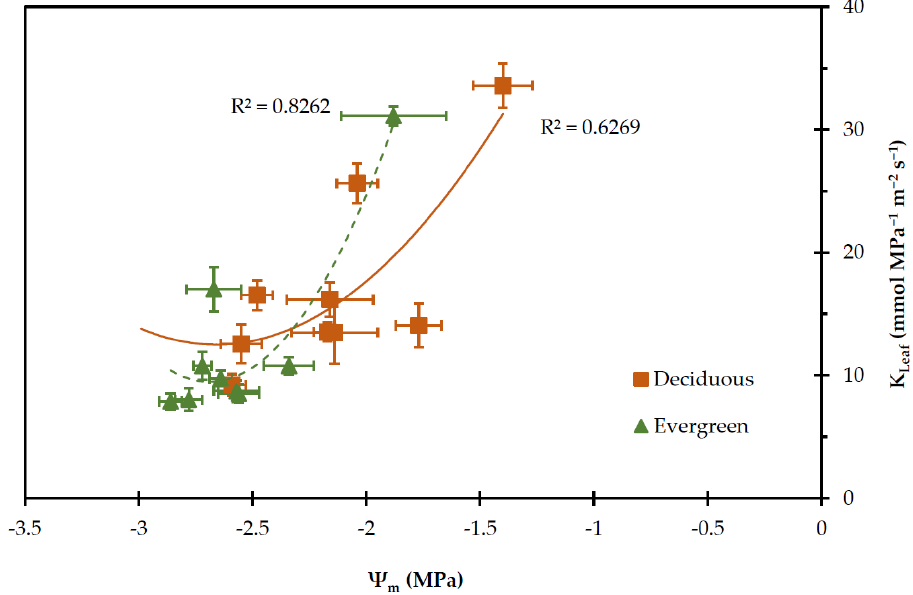
Figure 8. The relationship between midday leaf water potential ( Ψ m ) and hydraulic conductance (K Leaf ) of deciduous and evergreen shrubs during the experimental period, from 27 May to 28 August. Values are means ± SE ( n = 24). Polynomial regression analysis was used to assess the relationship between K Leaf and Ψ m .